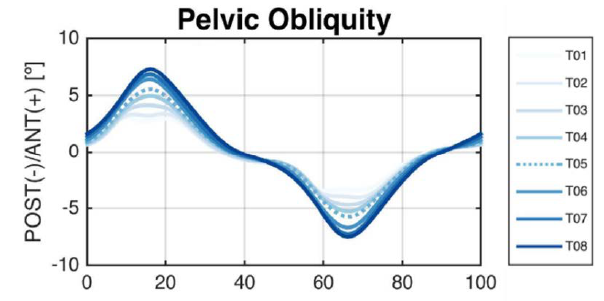
Fig. 2 Derivative function